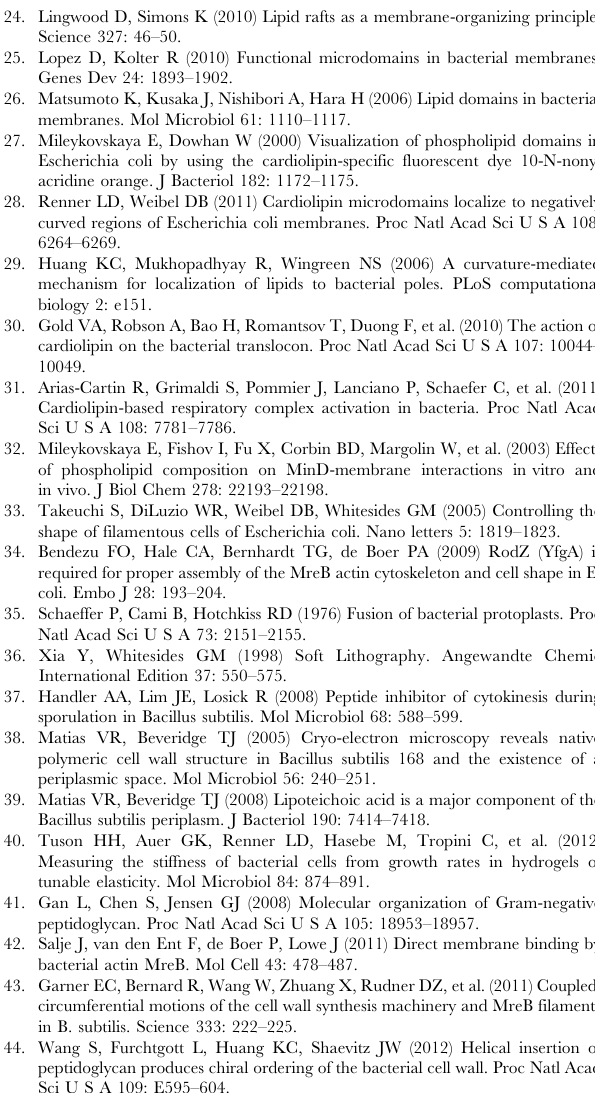
curve tool, the radius was measured by aligning a sphere into the curve, then the radius was converted into curvature. Figure S2 Mean values for spacing between MreB foci and statistical analysis/comparison (t-test) of the spac- ing of MreB between the positively and negatively curved regions of the bacterial cells. Comparison between data points with asterisks is statistically significant (***P , 0.001, one sample t-test, null hypothesis: mean value negative curvature for each angle value). Figure S3 Examples of MreB distribution analyses. We analyzed the number of fluorescent clusters along a drawn line at the engineered curvature region of the microchannel (as shown exemplarily in Figure S3, the red line representing the outer and the black line representing the inner curvature) using ImageJ (NIH, Bethesda, MD) and plotted the density versus the channel length. We then measured the peak-to-peak distance directly in the